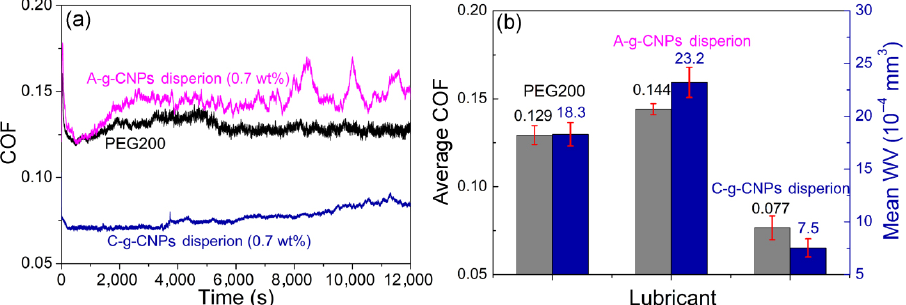
Fig. 12 (a) COF curves, (b) average COF and mean WV of disks lubricated with PEG200, and A-g-CNPs and C-g-CNPs dispersions (0.7 wt%) in PEG200 under the conditions of 100 N and 200